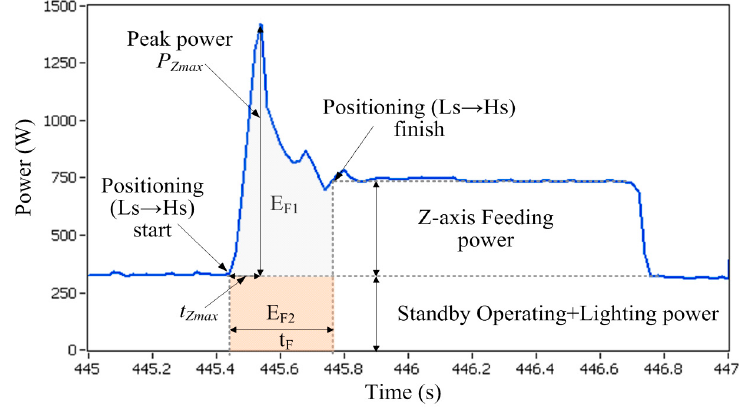
Figure 7. Power curve of positioning (Ls → Hs).